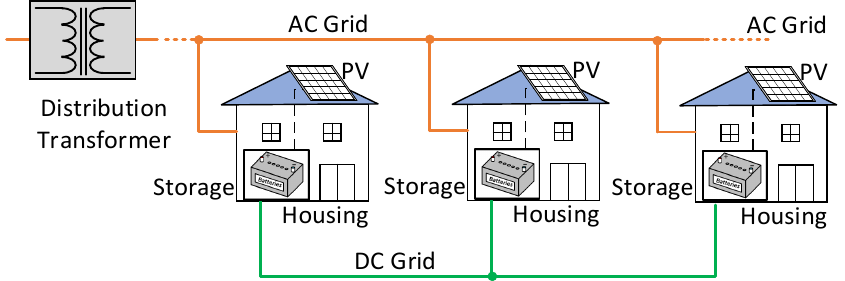
Figure 14. A perspective on parallel AC and DC infrastructure in LV electrical networks.